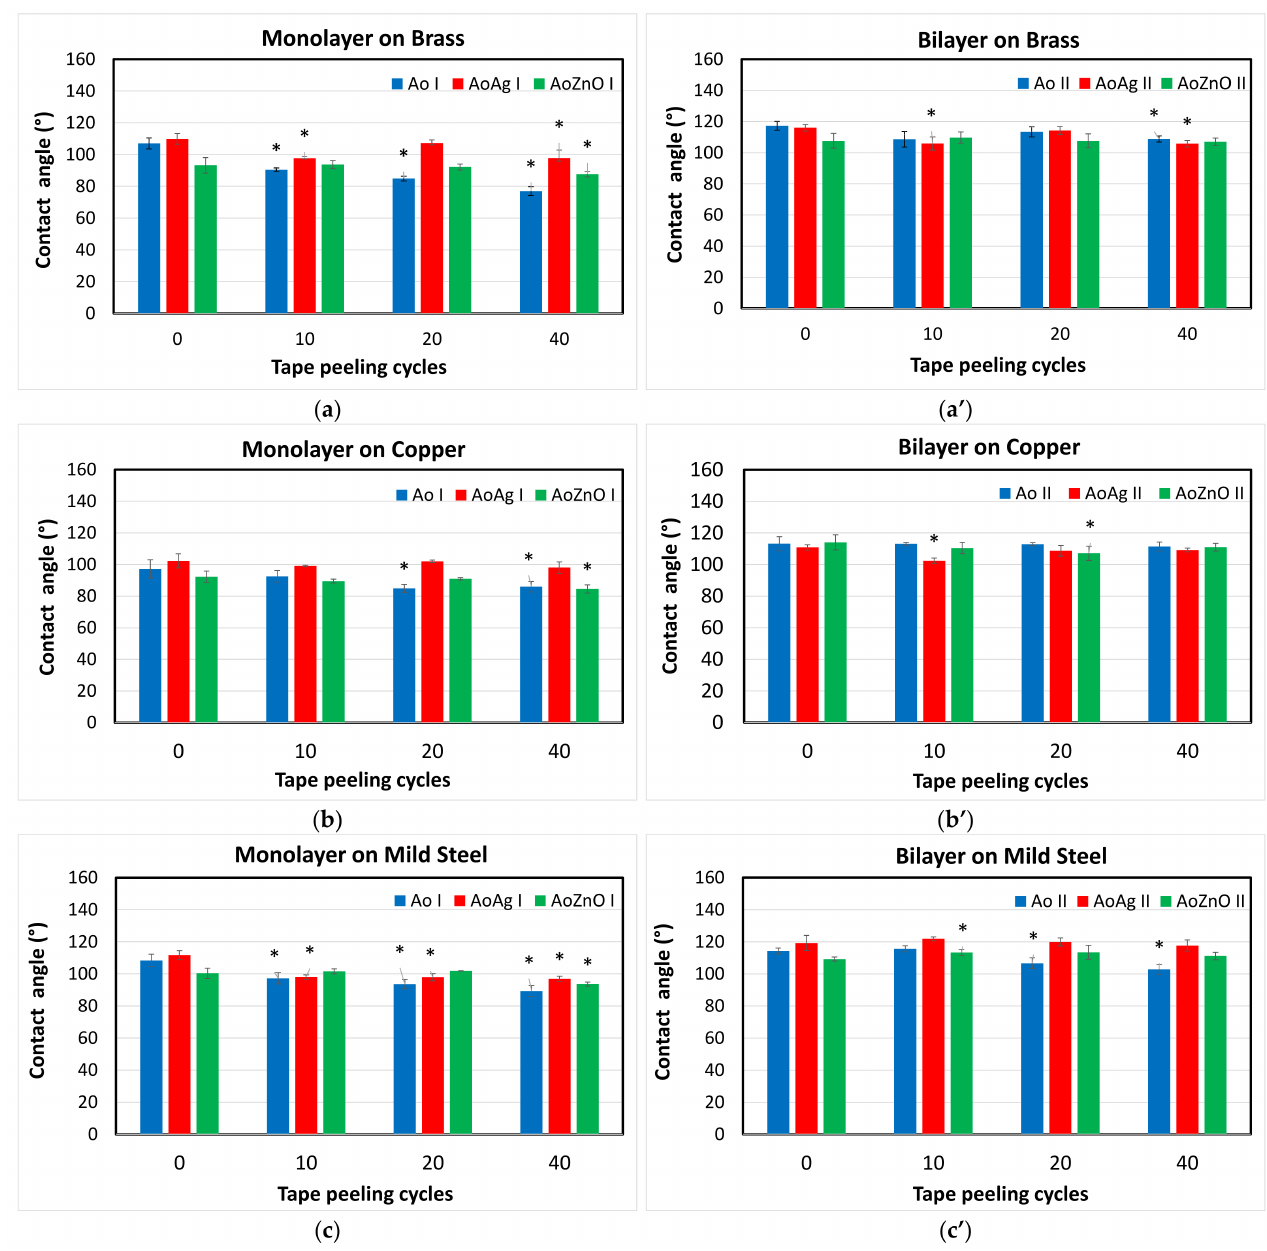
Figure 4. The average contact angle values measured for the mono- ( a – c ) and bilayer ( a’ – c’ ) coatings deposited on different metallic surfaces, initial and after 10, 20 and 40 peeling cycles (* p < 0.05 vs. original coated metallic substrate, before the tape peeling